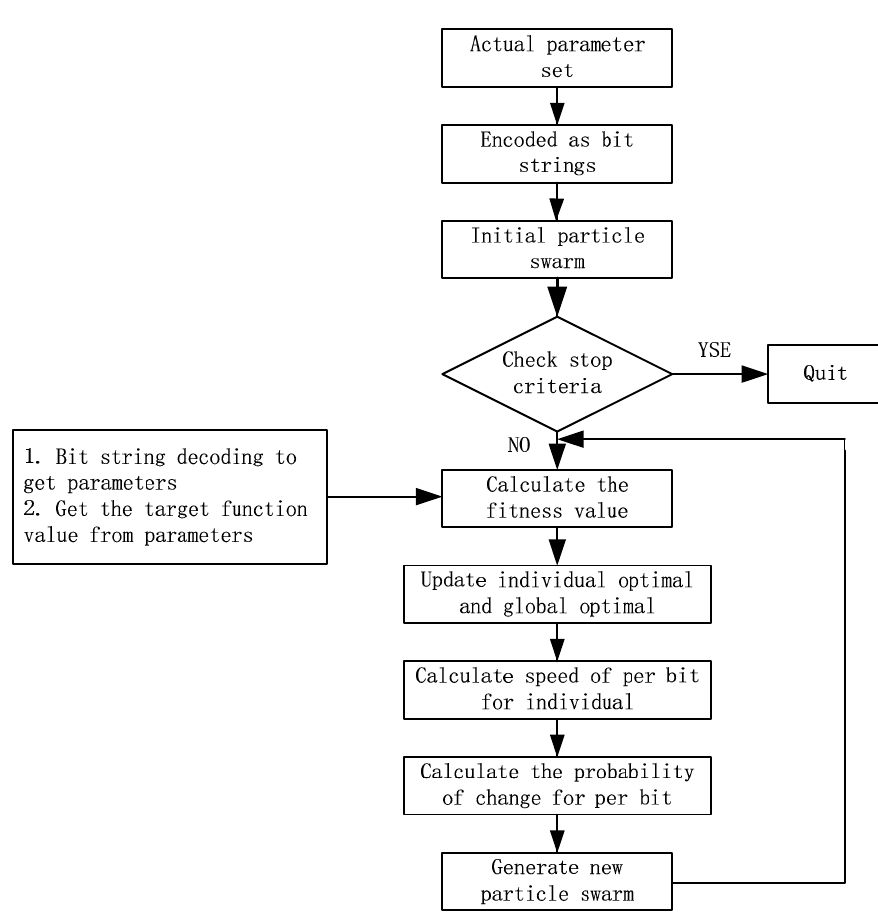
Figure 5. The flow chart of improved binary particle swarm optimization (IBPSO) algorithm.